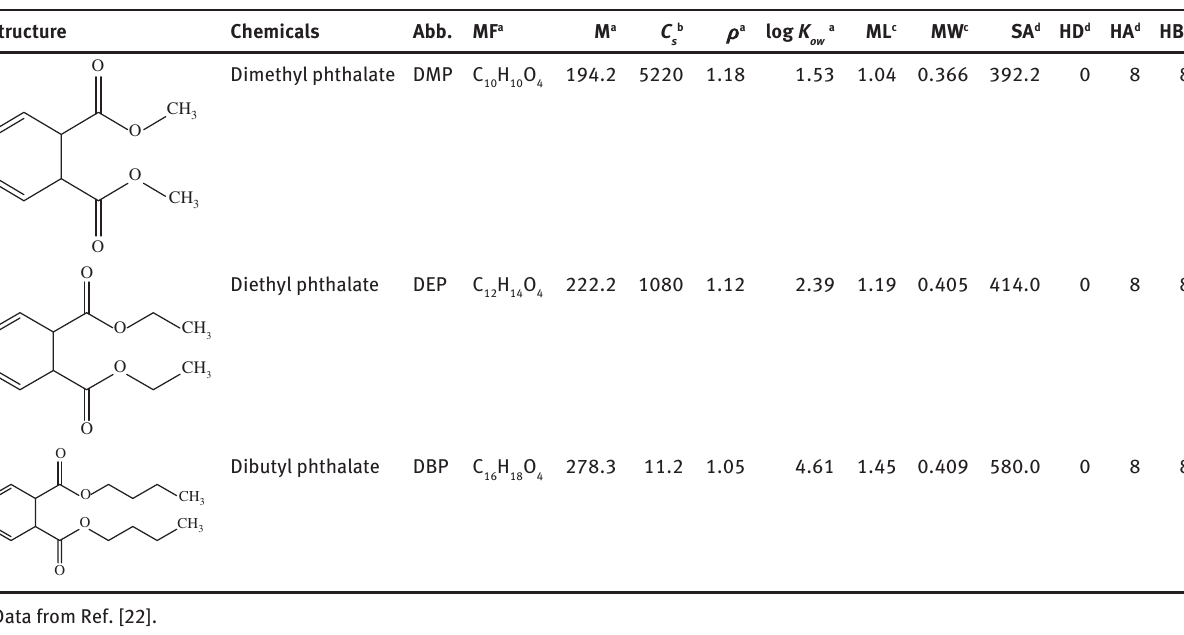
Table 1: Selected physico-chemical properties of the phthalic acid esters (PAEs).